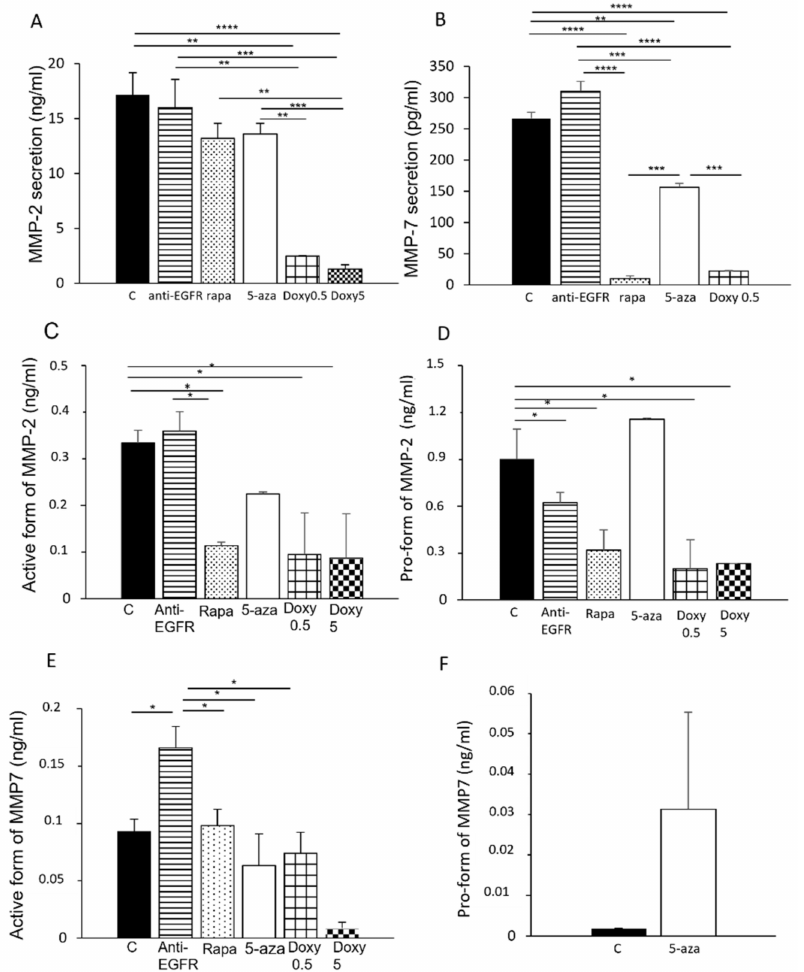
Figure 3. MMP-2 and MMP-7 secretion following treatment with anti-EGFR antibody and rapamycin and after tuberin expression. MMP-2 ( A ) and MMP-7 ( B ) secretion were evaluated by ELISA assay in control LAM/TSC cells and after incubation, for 48 h with anti-EGFR antibody, rapamycin, and doxycycline, and for 96 h with 5-azacytidine. The active form ( C ) or the pro-form ( D ) of MMP-2 was evaluated by using a QuickZyme assay in the culture medium of control LAM/TSC cells ( C ) and in cells incubated with anti-EGFR antibody, rapamycin, doxycycline (0.5 µ M and 5 µ M), and 5-azacytidine. The active form ( E ) or the pro-form ( F ) of MMP-7 was analyzed with a QuickZyme assay in the same experimental groups as in ( E ). Data represent means ± SEM of three independent experiments. ANOVA with Tukey test ± SEM ( n = 3 experiments) * p < 0.05; ** p < 0.01 *** p < 0.001; **** p <